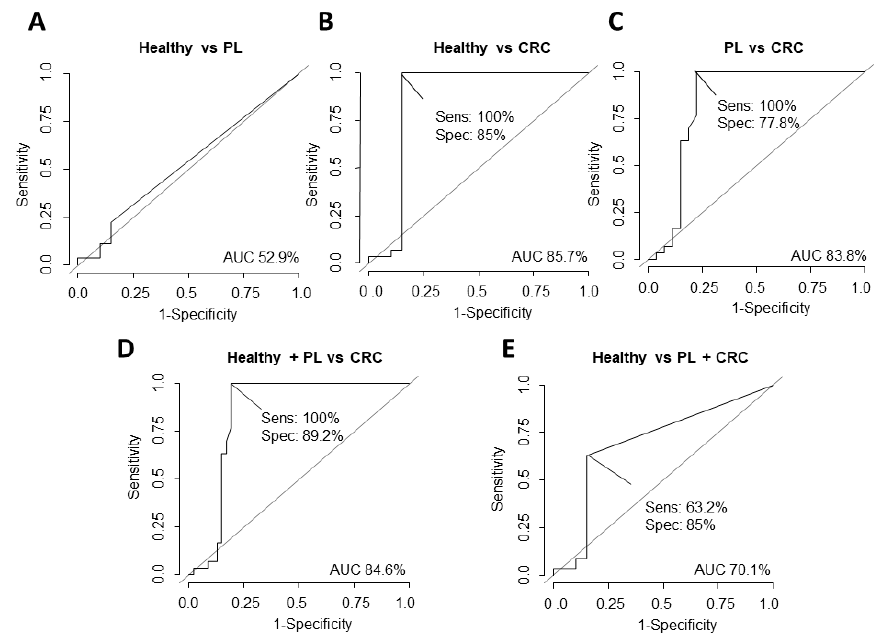
Figure 5. Determination of the diagnostic potential of CEA levels in plasma to discriminate healthy subjects versus subjects with PL ( A ), healthy subjects versus patients with CRC ( B ), subjects with PL versus patients with CRC ( C ), healthy + PL subjects versus patients with CRC ( D ), and healthy subjects versus PL subjects + patients with CRC ( E ) carried out through ROC curves calculating AUC, its specificity (spec) and sensitivity (sens).